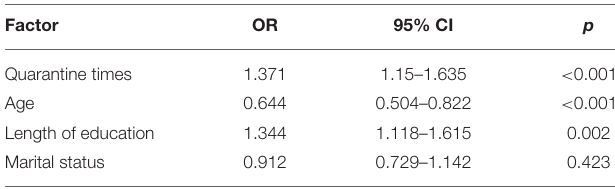
TABLE 4 | Multivariate logistic regression to identify independent predictors of symptoms of depression, defined as PHQ-9 score >